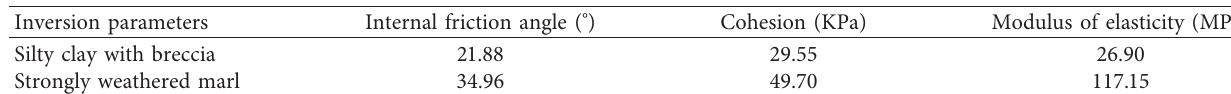
Table 3: Inversion value of soil parameters.